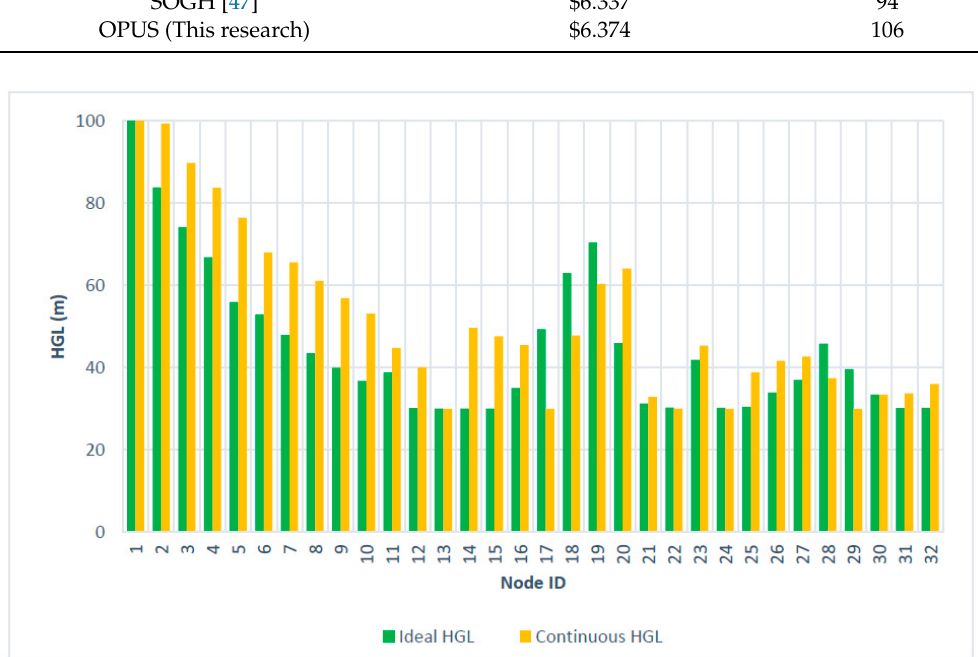
Figure 9. Comparison between the ideal HGL and that obtained by OPUS considering the additional 50 in. diameter.